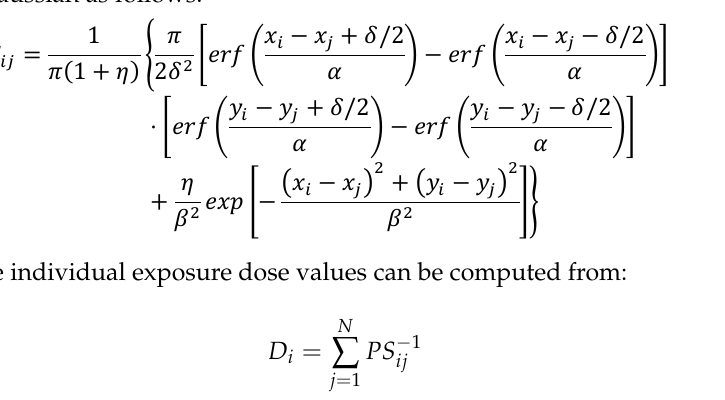
Figure 2. ( a ) Schematic diagram of the electron beam exposure points. ( b ) Schematic diagram of the exposure dose at each point in the 100 nm square region calculated by MATLAB (2016b, MathWorks, CA, USA). ( c ) Electron micrograph of a square 2D grating structure without proximity effect correction, with a side length of 100 nm. ( d ) Electron micrograph of a square 2D grating structure with proximity effect correction, with a side length of 100 nm.